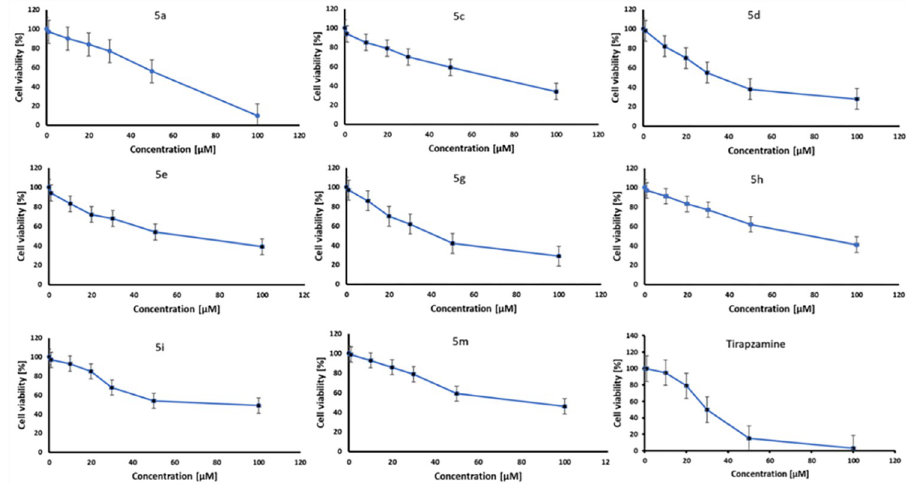
Fig 3. Fuberidazole derivatives affect MCF-7 cell viability in hypoxia. The WST-1 test was used to determine cell viability after 48 h of the treatment. The findings were given as a mean ± S.D., n =